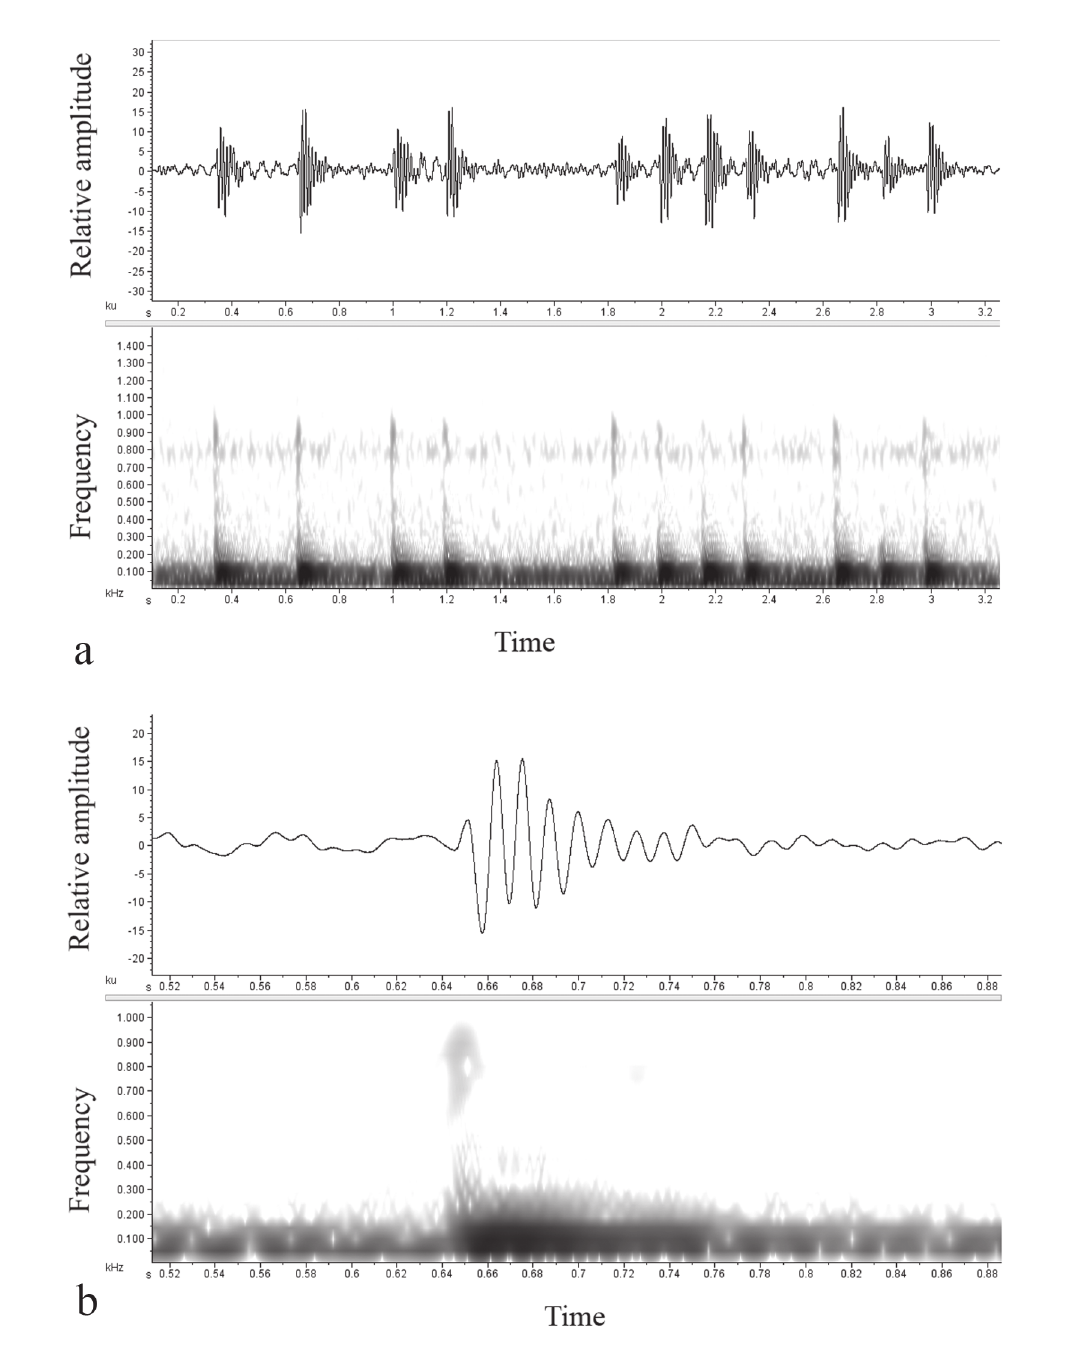
Fig. 2. General thump sequence produced by the male of Cynolebias parnaibensis during the courtship behavior ( a ), and a single thump expanded (the second one above) ( b ). Oscilogram above and spectogram below (window function Hann, overlap 99%, FFT size 1,200